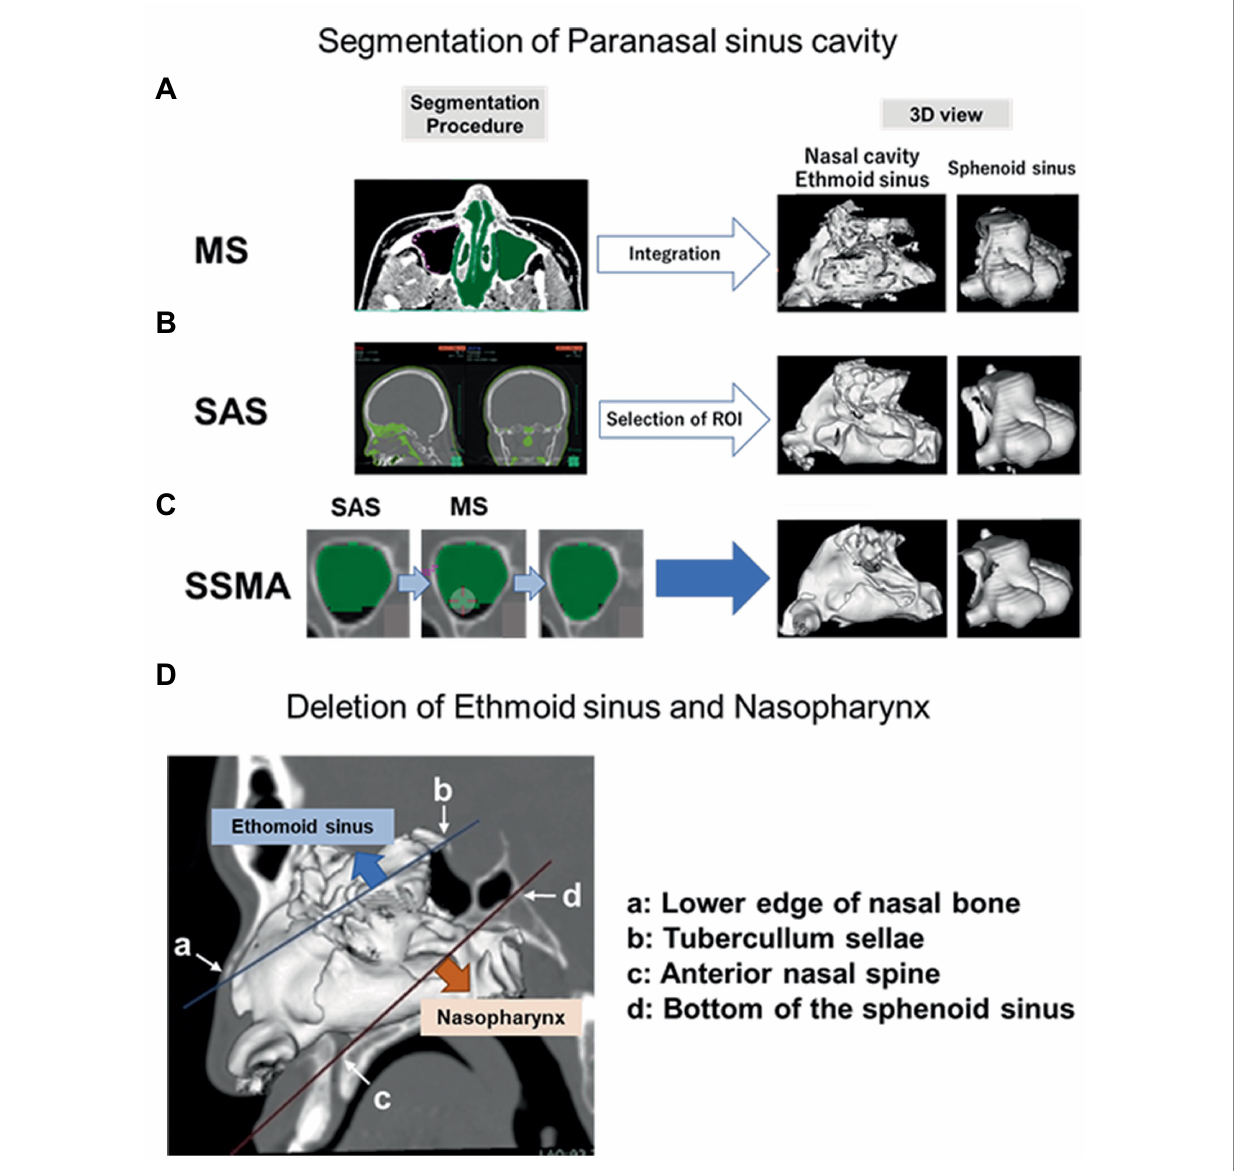
FIGURE 1 Procedures for each surgical simulation method. Regions determined by MS, SAS, and SSMA. Detailed procedures of each method (left panel) and 3D models of the nasal cavity, ethmoid sinus, and sphenoid sinus (right panel) are shown. (A) In the MS procedure, we drew a region of interest around the lesion boundaries on each slice where the lesion was observed. The area was multiplied by the slice thickness to calculate the volume of the lesion within that slice, and the volumes from all slices were added to yield the total lesion volume. (B) A set of voxels was extracted from the preoperative CT in the value range of [ − 1,500 −− 200] HU (air density) in the SAS. (C) Unextracted regions in the nasal cavity and each paranasal sinus were manually collected after performing the same procedures in SSMA. (D) Deletion areas of the ethmoid sinus and nasopharynx on the sagittal section are shown. MS, manual segmentation; SAS, semiauto segmentation; and SSMA, semiautomatic segmentation with manual